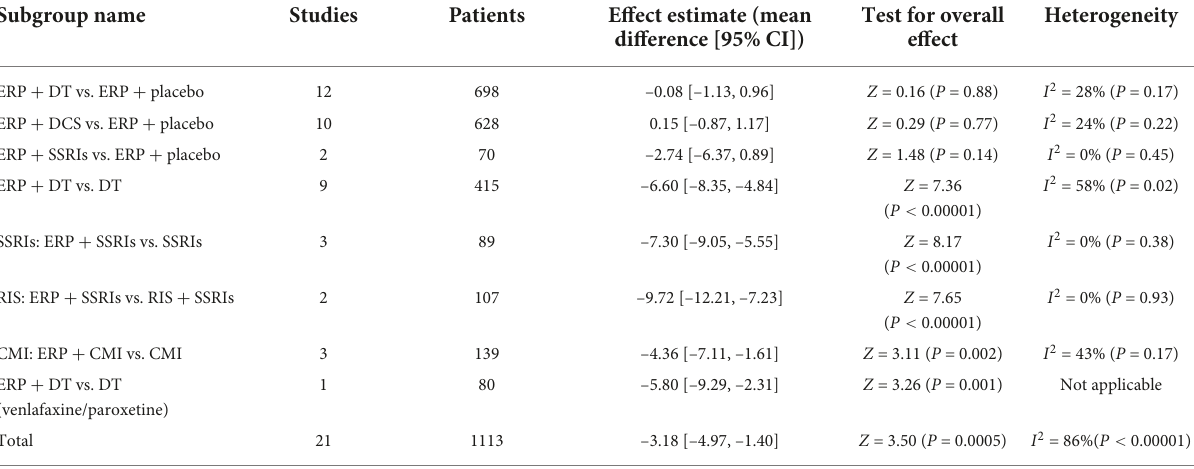
TABLE 2 Treatment efficacy of psychological and pharmacological